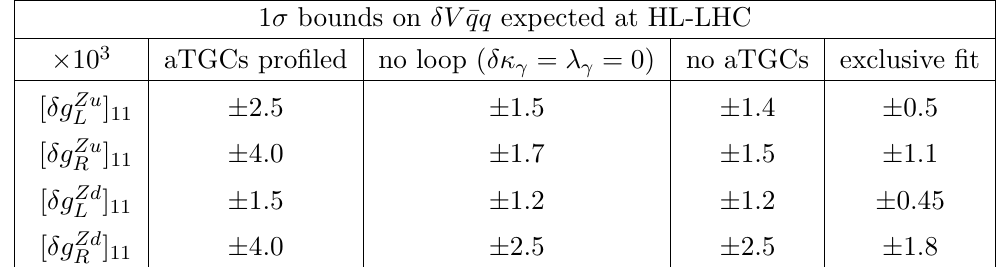
Table 5 . Expected constraints ( (cid:2) 10 3 ) at HL-LHC on the (cid:14)V (cid:22) qq vertex corrections. The constraints are obtained from the projections at HL-LHC for the pp ! W + W (cid:0) ! ‘(cid:23)‘(cid:23) channel combined with the LEP-1 constraints for a MFV setup. The (cid:12)rst column gives the constraints resulting from a seven parameter (cid:12)t. In the second, the two aTGCs usually generated at the loop level are set to zero. In the third column, all the three aTGCs are set to zero. Finally, the last column reports the constraints obtained from an exclusive (cid:12)t with only one parameter considered at a time.